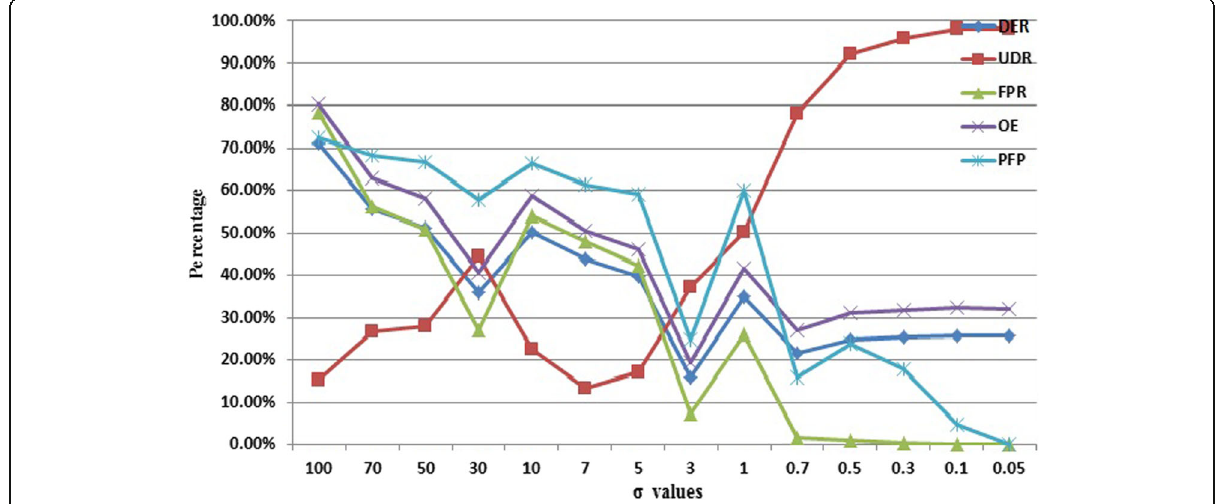
Fig. 5 The performance metrics of RBFSVM with different σ